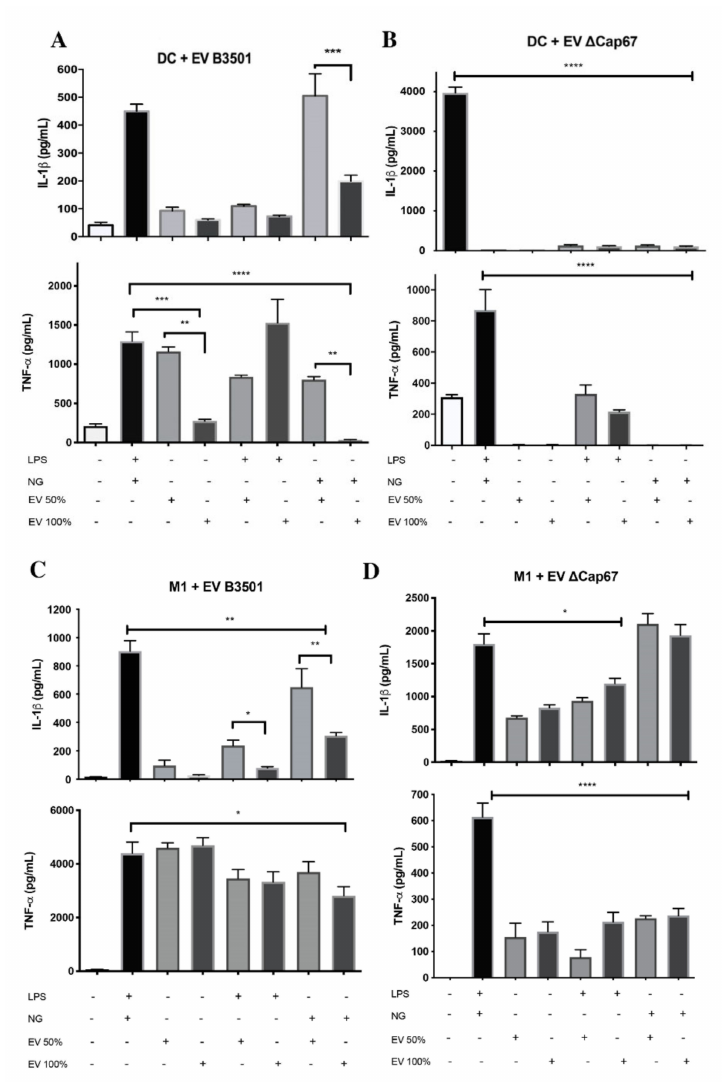
Figure 2. Extracellular vesicles modulate the production of inflammatory cytokines by bone marrow-derived dendritic cells (BMDCs) and bone marrow-derived macrophages (BMDMs). EVs (40 ng / mL of sterol content) isolated from C. neoformans strains B3501 ( A , C ) and ∆ Cap67 ( B , D ) grown in SDB 50% or in SDB 100% were incubated with 1 × 10 6 cells / mL of BMDCs ( A , B ) or BMDMs ( C , D ) in the presence or not of lipopolysaccharide (LPS, 500 ng / mL) and / or nigericin (20 µ M) for 24 h at 37 ◦ C and 5% CO 2 followed by determinations of cytokine production by enzyme-linked immunosorbent assay (ELISA). * indicates significant di ff erence p < 0.05, ** indicates p < 0.01, *** indicates p < 0.001, **** indicates p < 0.0001 according to one-way ANOVA. The data are expressed as the mean ± SEM of triplicates and represent at least three independent